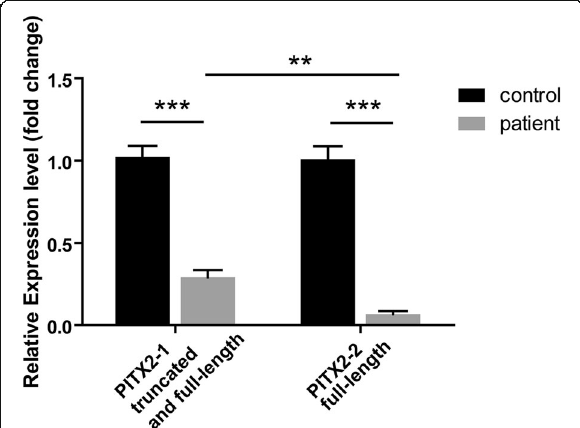
Fig. 4 The mRNA expression of PITX2 in lymphocytes of the affected individuals and the controls. The mean expression (±SEM) of PITX2 mRNA in affected individuals ( n =3) and controls ( n =3) was measured by quantitative real-time PCR by primers before (PITX2 – 1) and after (PITX2 – 2) the mutant site. PITX2 – 1 columns represent both truncated and full-length pitx2 transcripts, while PITX2 – 2 columns indicate the full-length PITX2 mRNA. **, p <0.05; ***, p